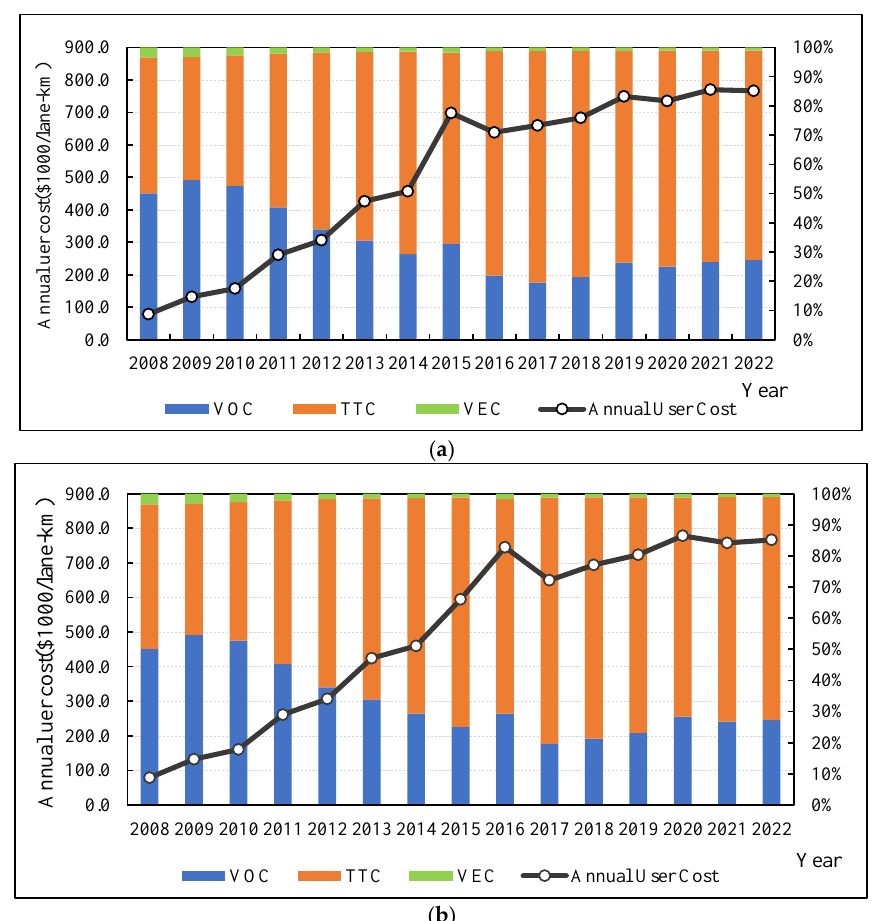
Figure 6. Annual user cost and their compositions in the typical and actual activity profiles. ( a ) Typical Activity Profile ; ( b ) Actual Activity Profile .